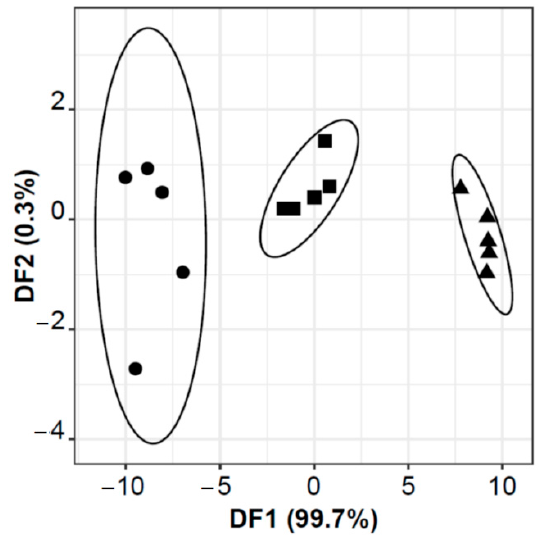
Figure 4. E ‐ tongue ‐ LDA discrimination of canned tuna according to the EVOO used: ● greenly light fruity sensation ; ■ greenly intense fruity sensation; and, ▲ ripely fruity sensation 2D ‐ plot of the first two discriminant functions (DFs) based on the potentiometric signals recorded by six lipid sensor membranes (S1:1; S1:7; S2:1; S2:4; S2:12; and S2:19), selected by the SA algorithm.